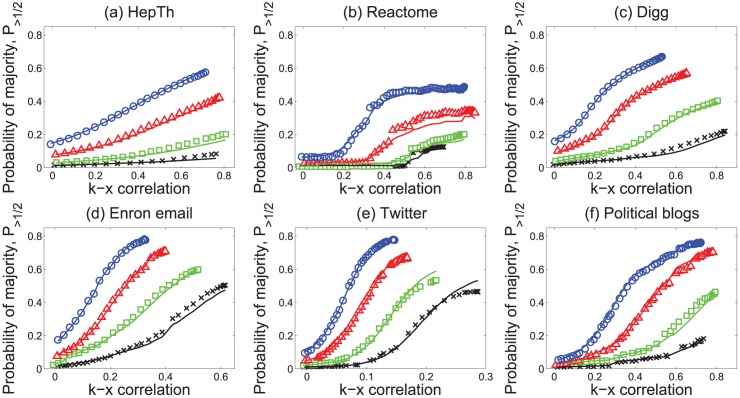
“Majority illusion” in real-world networks.Magnitude of the illusion in real-world networks as a function of degree–attribute correlation ρkx for different fraction of active nodes P(x = 1). The lines represent calculations using the statistical model of Eq (5). The plots are arranged in order of degree assortativity, from highest (a) to lowest (f). Blue circles correspond to the fraction of active nodes P(x = 1) = 0.3, red triangles to P(x = 1) = 0.2, green squares to P(x = 1) = 0.1, and black crosses to P(x = 1) = 0.05.